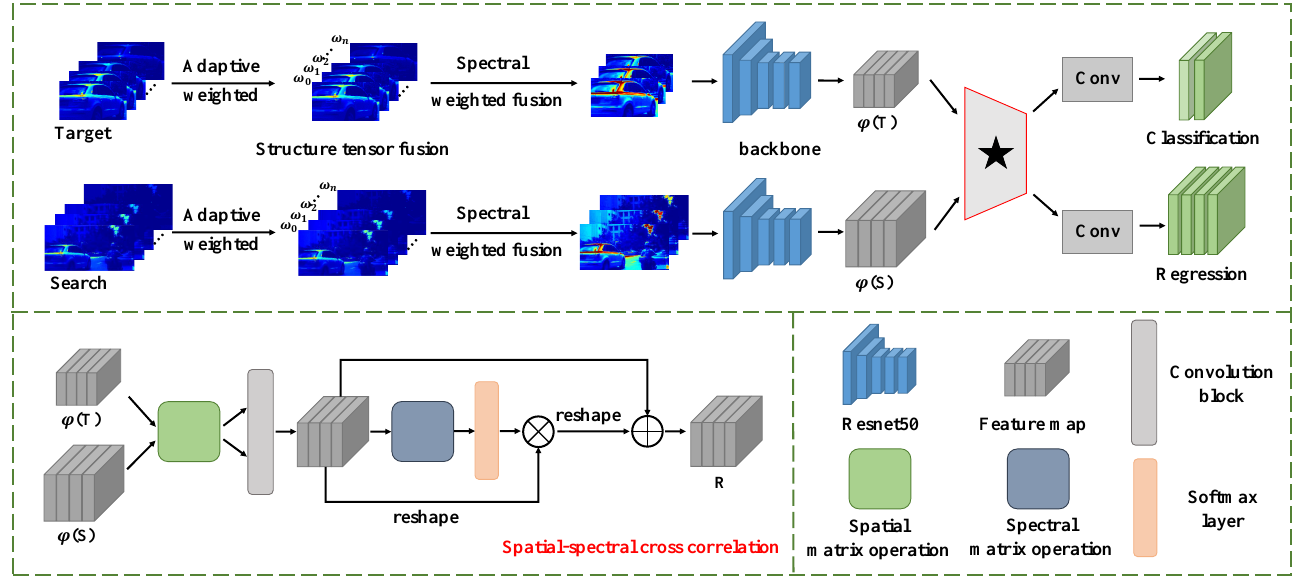
Figure 2. Illustration of the proposed SSDT-Net. Given the search region and target template, the network first reduces the dimensionality of HSIs through a spectral adaptive weighted fusion module, then uses a Siamese convolutional network for multi-channel response mapping extraction, and finally utilizes our proposed spatial–spectral cross-correlation module (denoted by (cid:56) ) to embed the information between the two branches of the Siamese network to obtain response maps for regression and